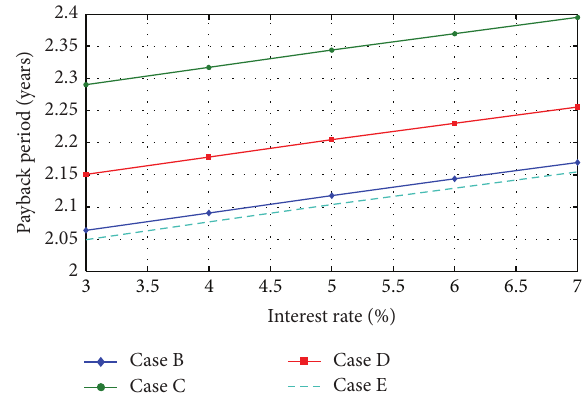
Figure 6: Effect of interest rate on payback period for four different cases.